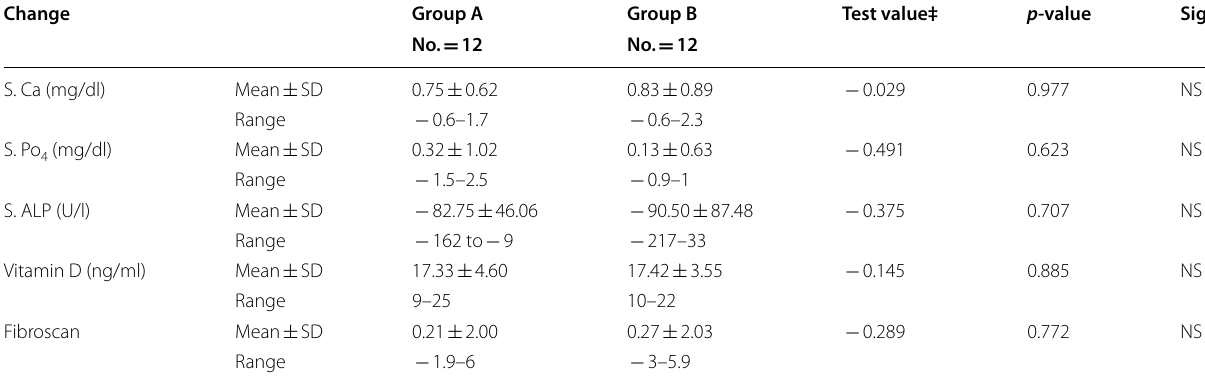
Table 8 Comparing metabolic profile, vitamin D level and fibroscan changes after vitamin D supplementation between both groups